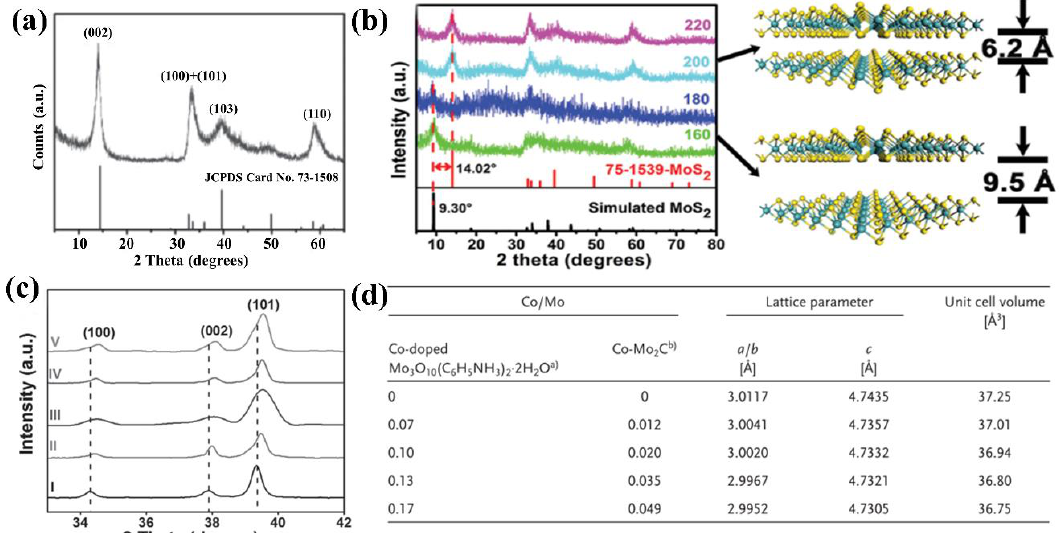
Figure 6. ( a ) XRD pattern of defect-rich MoS 2 ultrathin nanosheets. Copyright 2013 Wiley. ( b ) XRD patterns of MoS 2 /N-RGO-T nanocomposite prepared at different temperatures from 160 to 220 °C, at